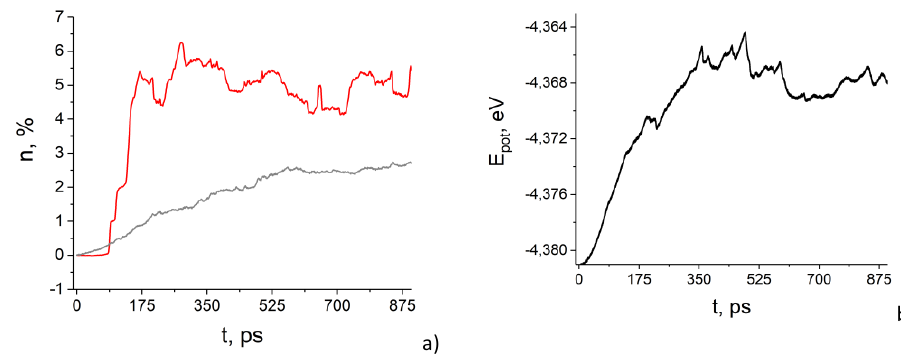
Fig. 4. Fraction of atoms with a hcp (red curve) and indefinite (gray curve) symmetry of the nearest environment versus time (a). Potential energy per atom versus time (b).